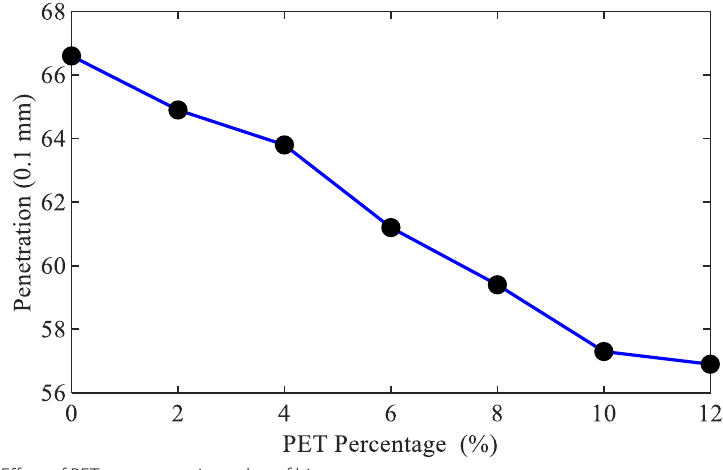
Fig. 12 Effect of PET on penetration value of bitumen